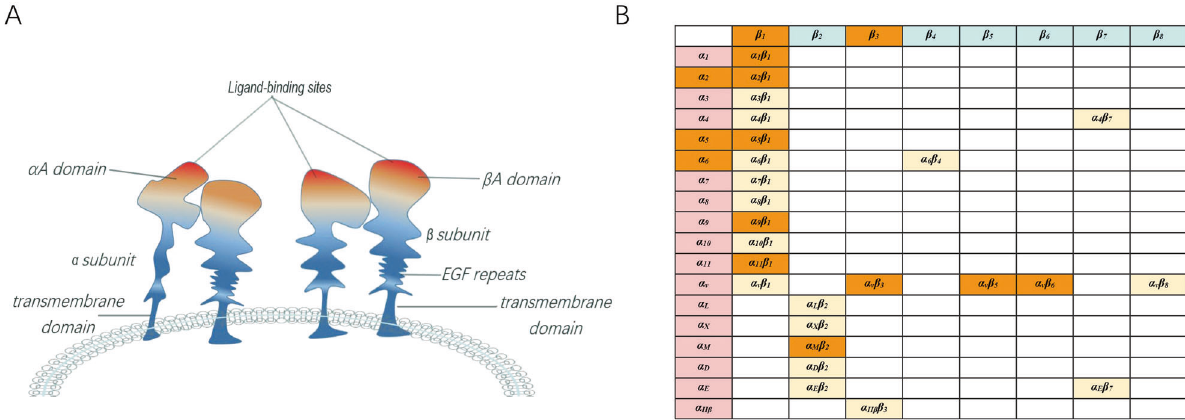
Fig. 1 Schematic representation of the structure and subtypes of the integrin family. A Schematic of integrins infrastructure. B Integrin family subunits and 25 existing subtypes. Orange integrins are active in bone